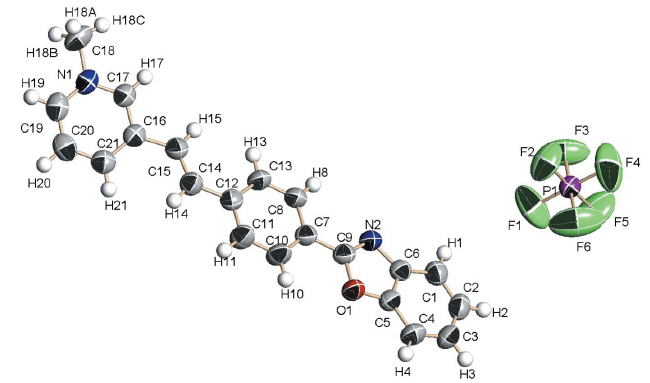
Figure 1 The molecular structure of the title salt with displacement ellipsoids drawn at the 50% probability